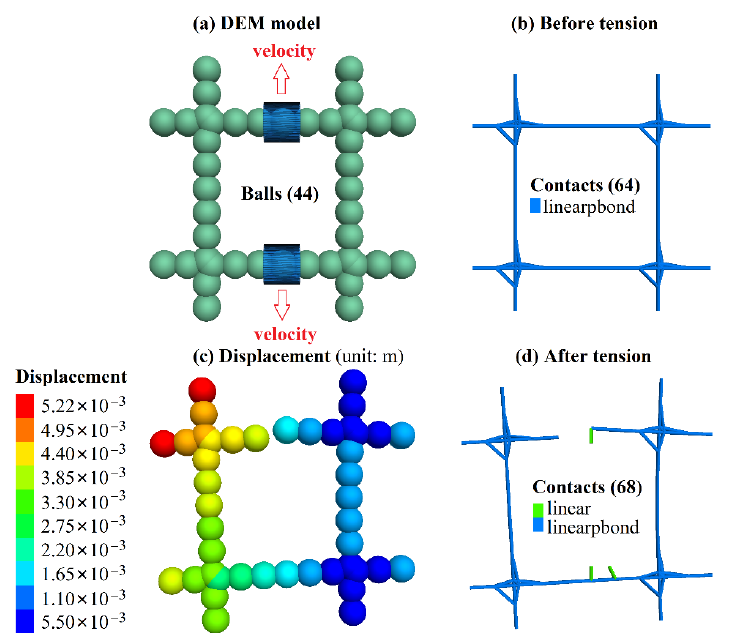
Figure 4. BFR mesh simulated by PFC3D. Table 3. Micro ‐ parameters of BFR.